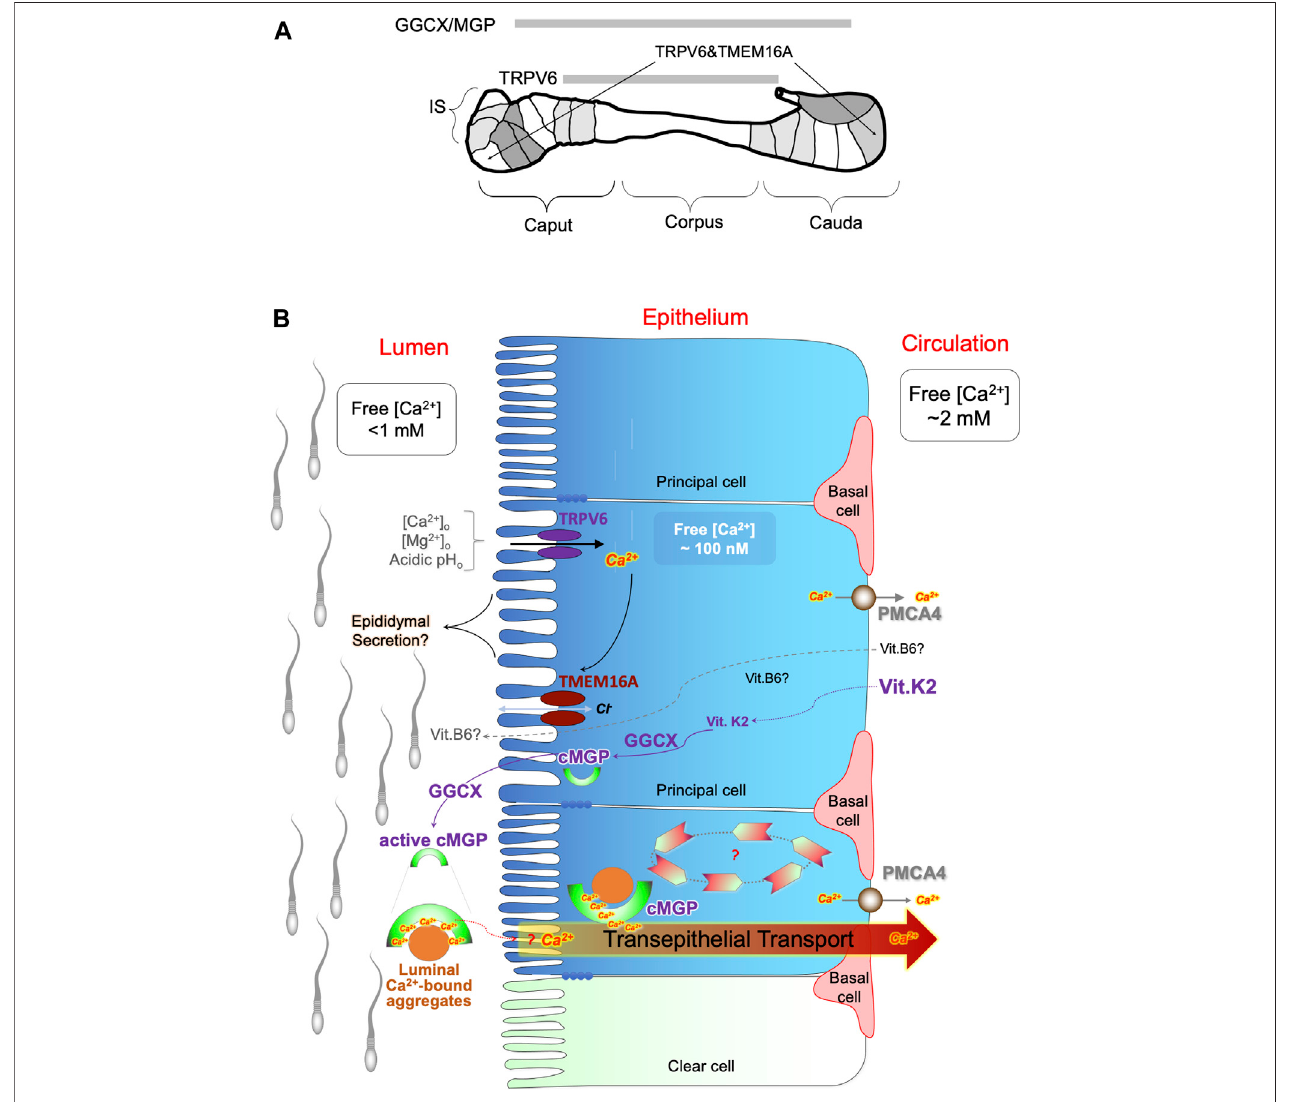
FIGURE 7 | Potential involvement of multiple vitamin pathways in regulation of epididymal Ca 2+ homeostasis. (A) Schematic illustration for the regional expression patterns of the key players regulating Ca 2+ homeostasis in the rat epididymis, including epithelial Ca 2+ channel TRPV6, Ca 2+ -dependent chloride channel TMEM16A, γ - carboxylase GGCX and its substrate MGP. IS: initial segment; caput, corpus and cauda indicate head, body and tail region of the epididymis. Spermatozoa mainly mature in the IS and caput epididymidis regions and are stored in the whereas cauda epididymidal region in a dormant stage. (B) Schematic diagram of the hypothetical model of Ca 2+ homeostatic regulation in the epididymal luminal microenvironment during sperm maturation. It involves vitamin D-associated electrical coupling ofTRPV6 and TMEM16A channels and vitamin K2-dependent GGCX carboxylation ofMGP for luminal Ca 2+ modulation and protein aggregation. The TRPV6- TMEM16Aelectricalcoupler isinvolvedin fl uid transportinamannerofsensitive toextracellularCa 2+ andpH. TheGGCX-dependentMGPcarboxylationplaysaroleina spatially complementary manner in the epididymis to promote Ca 2+ -facilitated protein aggregation, thereby maintaining Ca 2+ -homeostasis and pathological calci fi cations. The potential role of vitamin-B6 in regulating the epididymal luminal microenvironment is also depicted in the proposed model. Ca 2+ -bound MGP- containing protein aggregates in the epididymal lumen act as scavengers in which Ca 2+ is an essential cofactor for the chelation of Ca 2+ -precipitable metabolites in the extracellular matrix, such as epididymal secretory proteins and shedded remnants from spermatozoa.